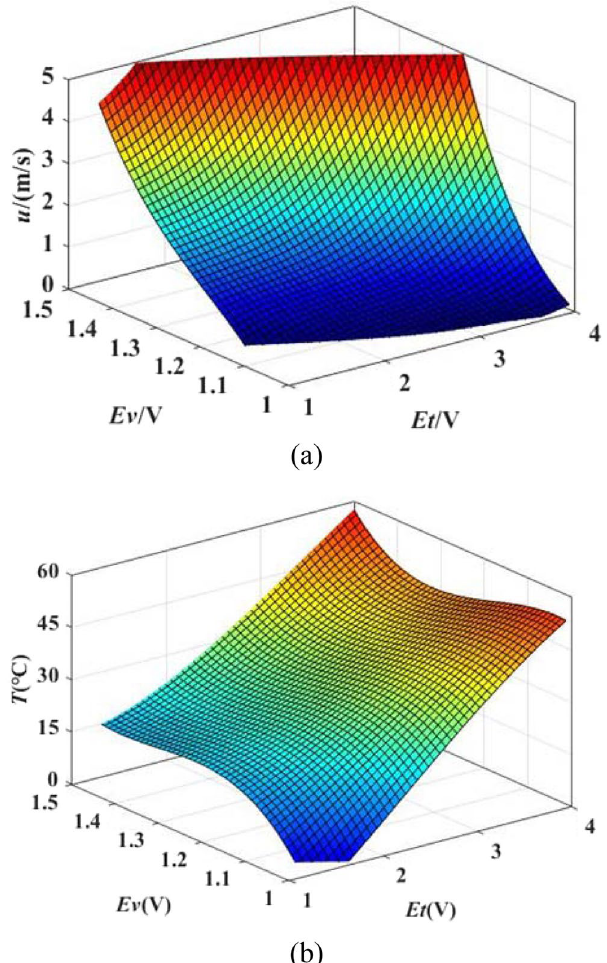
τ u 4.5% τ T 7.8% Table 2. Uncertainties of the main